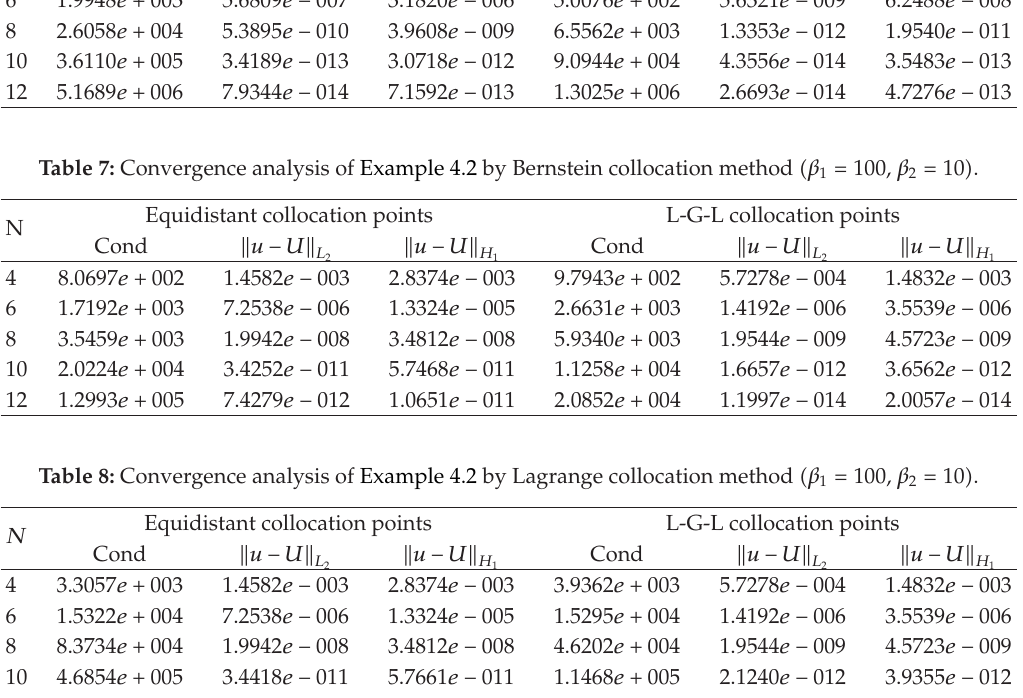
Table 6: Convergence analysis of Example 4.2 by Galerkin formulation.